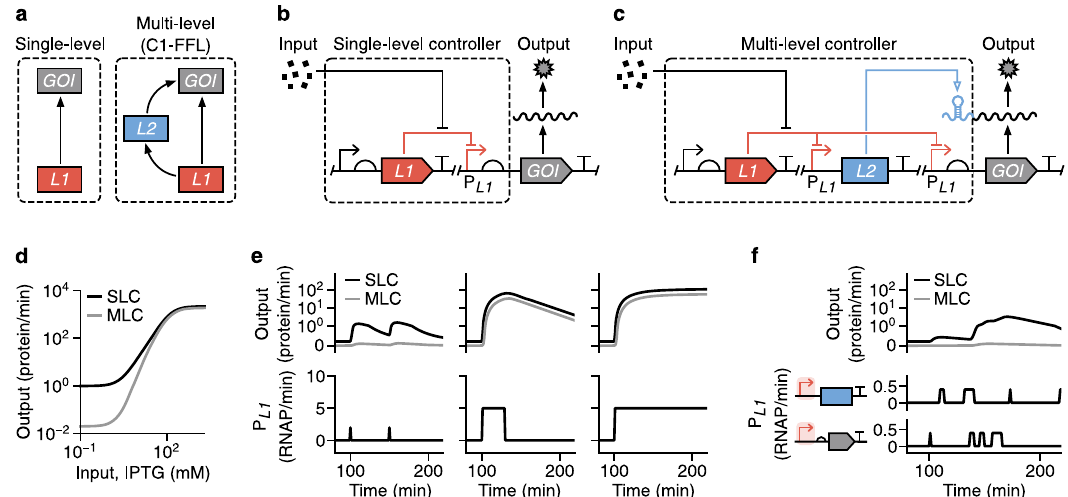
Fig. 1 Stringent control of protein expression through multi-level gene regulation. a Two possible regulatory schemes to control the expression of a gene of interest (GOI): (1) control using a single regulator ( L1 ), and (2) multi-level control using two separate regulators ( L1 and L2 ) connected in the form of a coherent type 1 feed-forward loop (C1-FFL). b Schematic of a genetic implementation of a single-level controller (SLC) that uses only transcriptional (red lines) regulation. An input (e.g. small molecule) modulates activity of the P L1 promoter and production of the GOI. c Schematic of a genetic implementation of a multi-level controller (MLC) that uses both transcriptional (red lines) and translational (blue line) regulation. An input (e.g. small molecule) modulates activity of the two P L1 promoters and an internal L2 regulator activates the translation of GOI transcripts to fi nally produce the output protein. d Steady- state response functions from mathematical models of the SLC and MLC. e Dynamic model simulations of the SLC and MLC and their response to different forms of temporal input (left to right): delta functions (P L1 activity = 2 RNAP/min for 1 min at 100 min and 150 min), a pulse (P L1 activity = 5 RNAP/min from 100 – 130 min), and a step function (P L1 activity = 5 RNAP/min from 100 min onwards). The activity of both P L1 promoters in the MLC is considered identical. f Dynamic model simulations of the SLC and MLC showing suppression of intrinsic promoter noise by the MLC. The two identical P L1 promoters for the L2 regulator and GOI are separately driven by independent and biologically realistic bursty transcriptional activity pro fi les